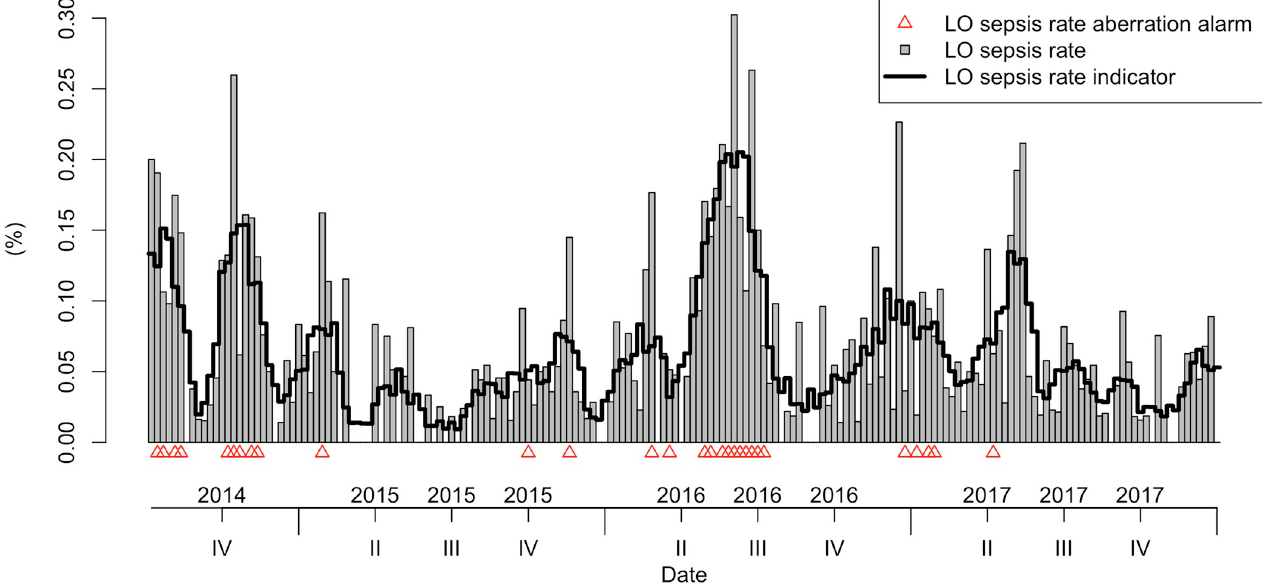
Fig 2. LO sepsis rate threshold outbreak alarm (red triangles) and the current smoothed LO sepsis weekly rate.